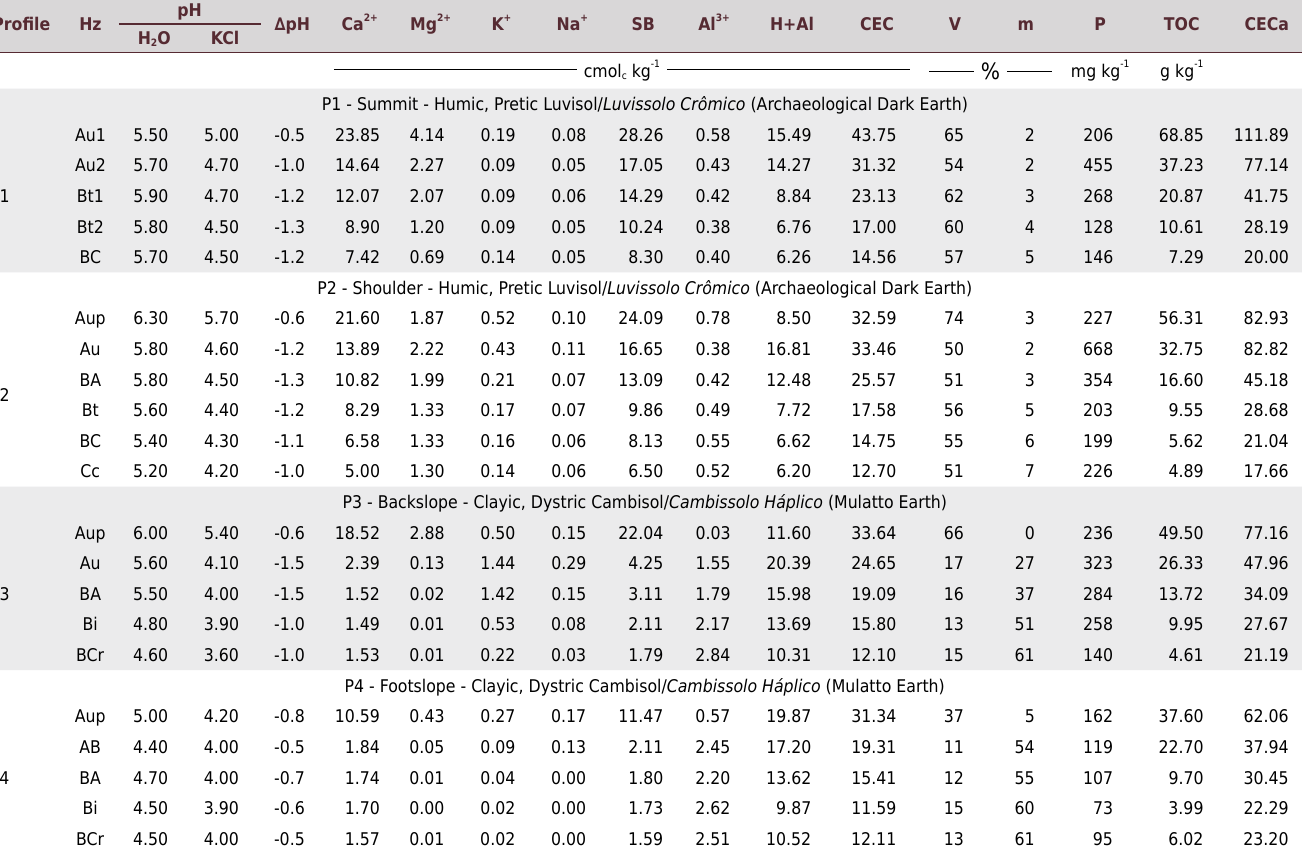
Table 3. Chemical properties of Archaeological Dark Earth and Mulatto Earth in western Amazonia, Brazil